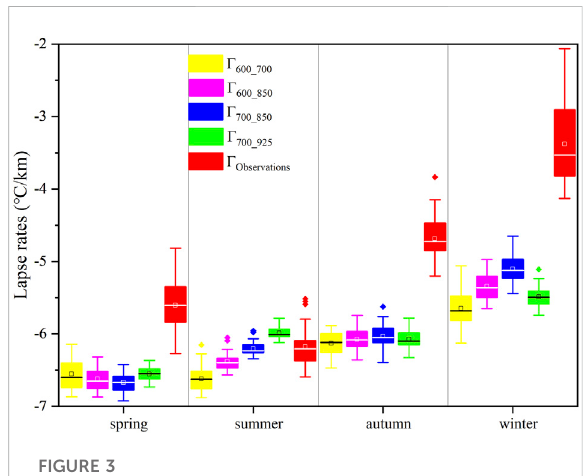
FIGURE 3 Box plots of seasonal mean Γ Obs and Γ ERA during the period 1979 ‒